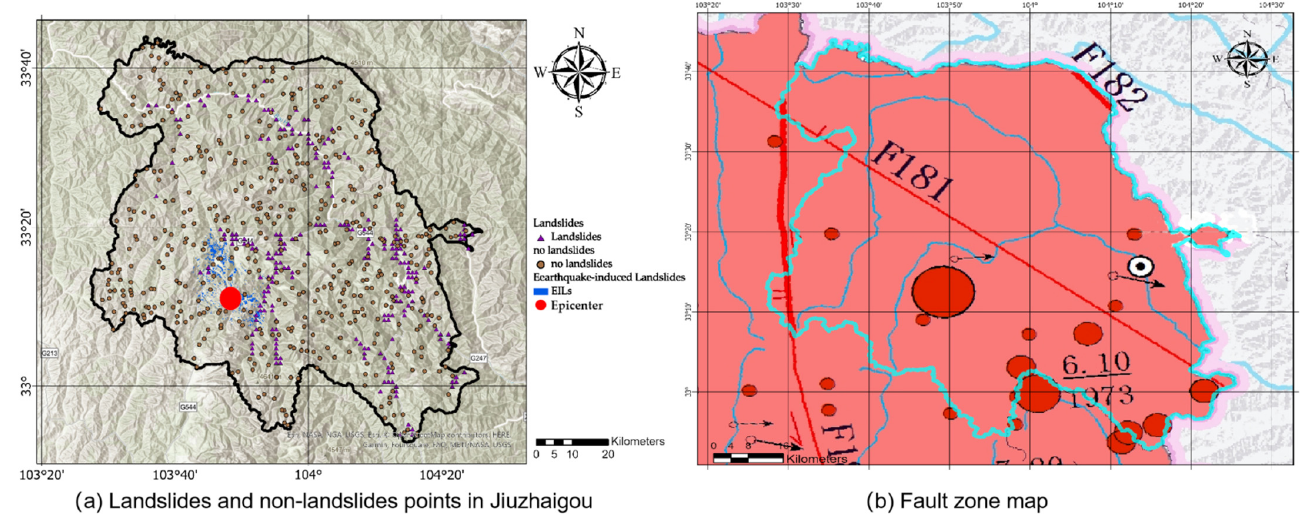
Figure 2. Landslides and faults in Jiuzhaigou. In ( a ), the purple triangles are pre-earthquake land- slides, and red dots are post-earthquake landslides. In ( b ), F180 (bottom left), F181 (middle), and F182 (top) are the Minjiang Fault, the Tazang Fault, and the Guanggaishan-Dieshan Fault, respec- tively.